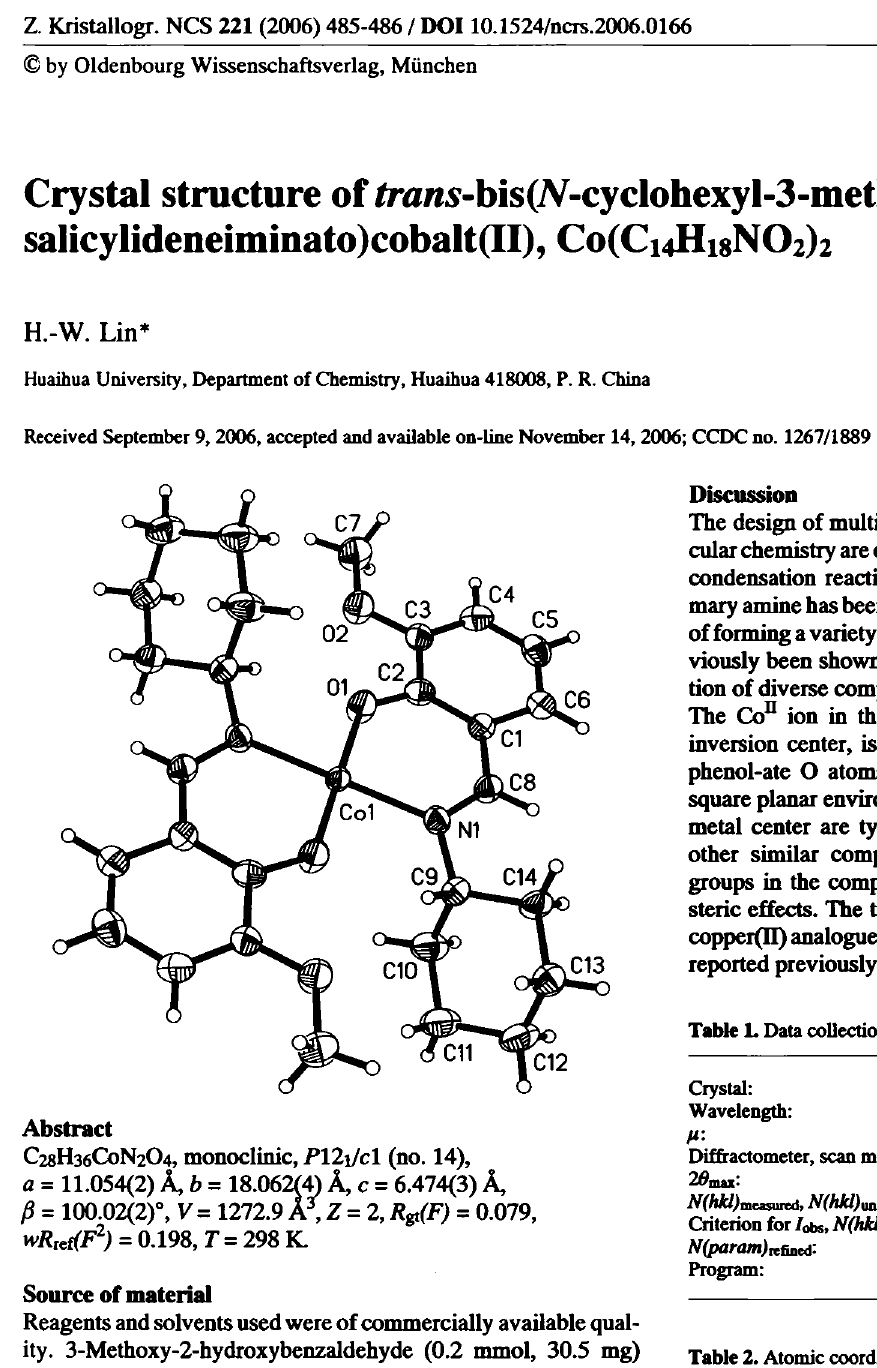
Table 2. Atomic coordinates and displacement parameters (in A 2